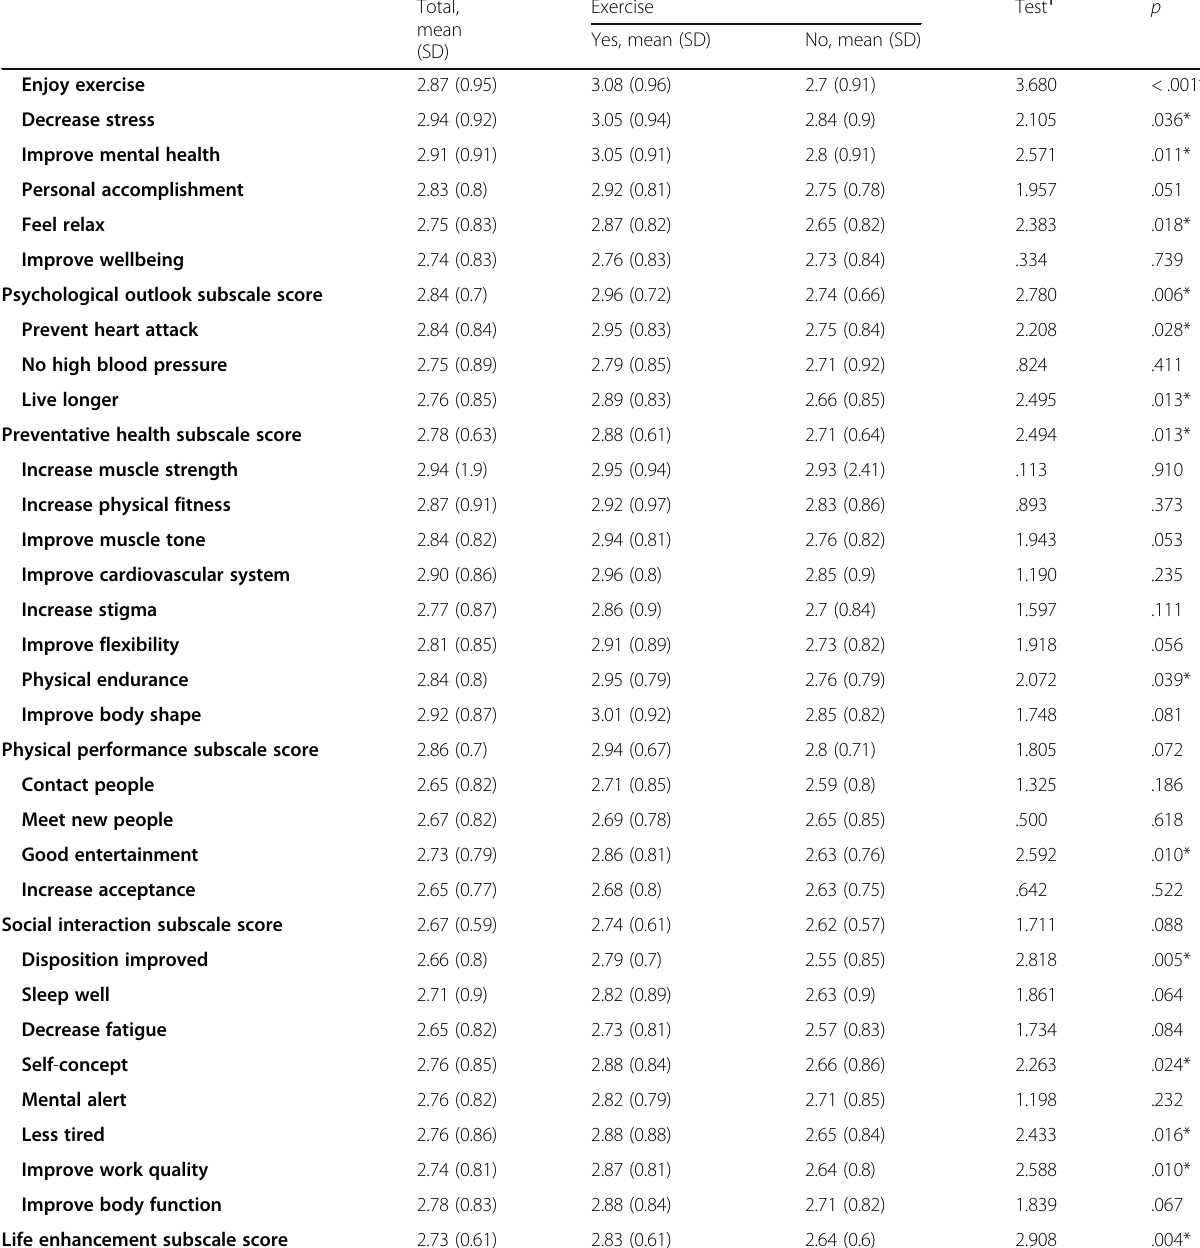
Table 3 Exercise benefits statements and subscales scores in terms of exercise